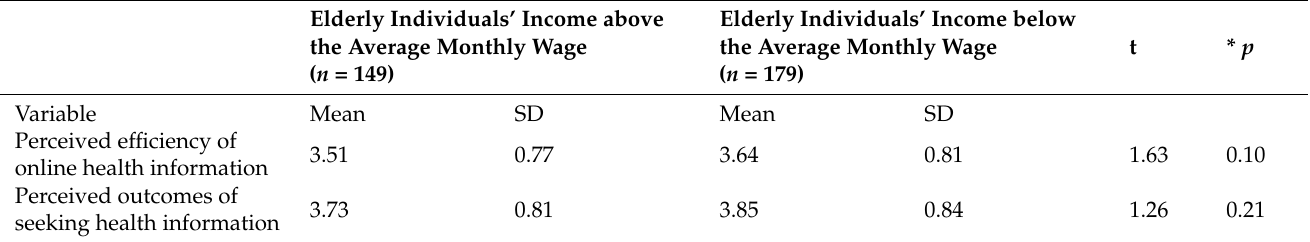
Table 2. Differences between elderly individuals’ income above and below average monthly wage regarding online health information efficiency and outcomes.